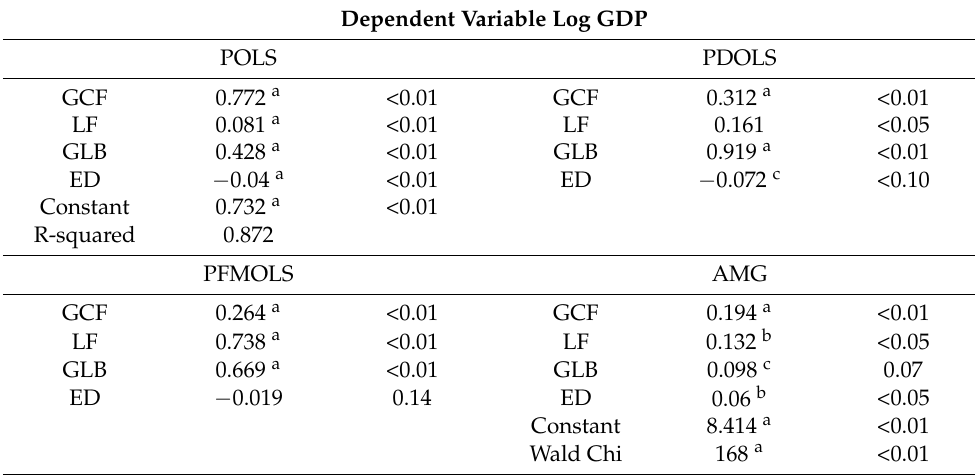
Table 3. Results of the POLS, the PDOLS, the PFMOLS, and the AMG